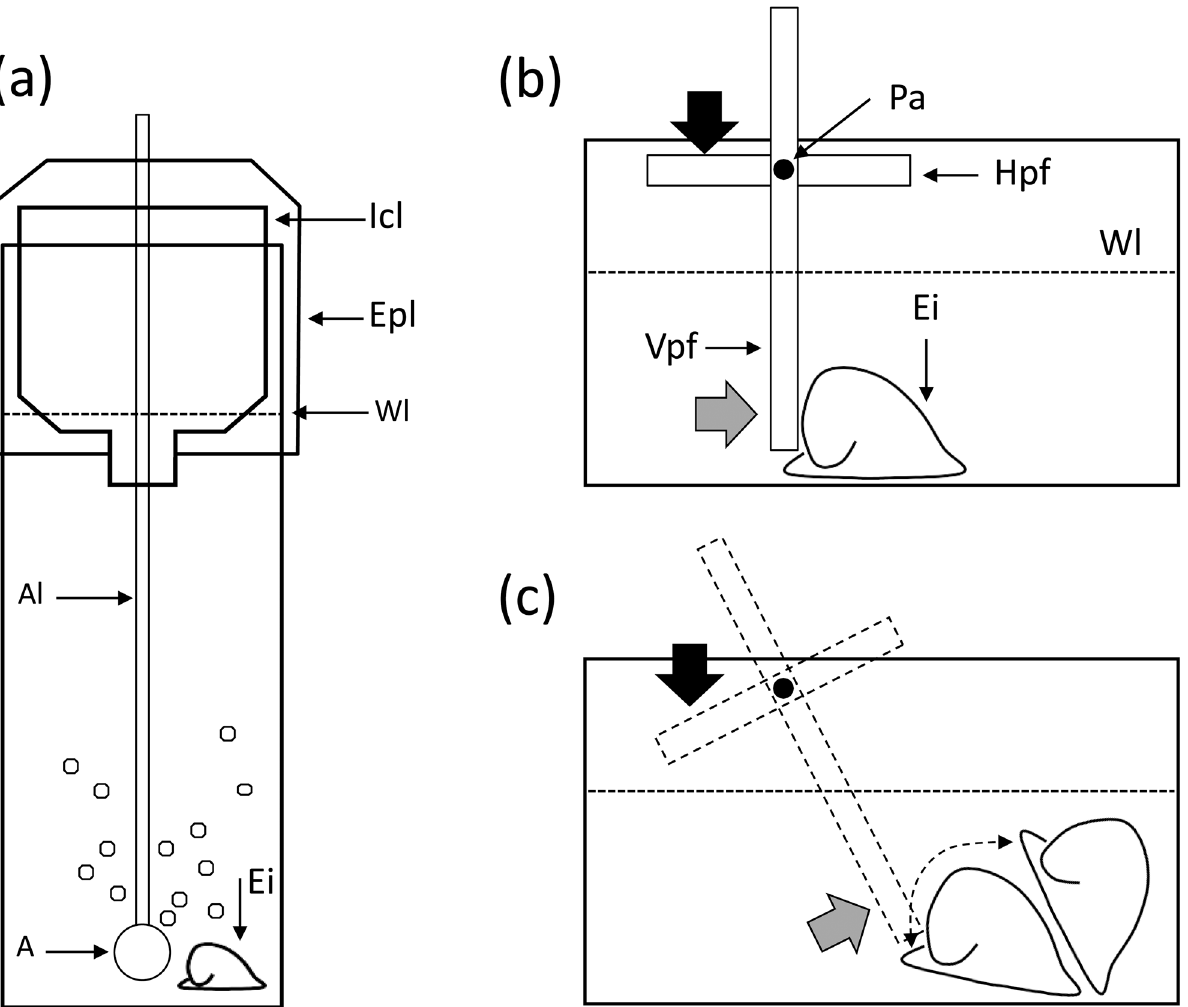
Fig 1. Schematic representations of the rearing bottles (a) and chamber used to measure dislodgement force (b-c). A: air stone, Al: plastic airline, Epl: external plastic lid; Icl: Internal conic lid; Pa: pivoting axis or fulcrum; Hpf: horizontal pivoting flap; Vpf: vertical pivotal flap; Wl: water level; Ei: experimental individual. In (c) the dashed contour depicts the position of the pivoting flap after the dislodgement force had been applied and the Ei was dislodged from the substratum. The black arrow depicts the point where the vertical force with the digital push-dynamometer was applied to the Hpf, and the grey arrow depicts the place where the resulting horizontal force of the Vpf was applied against the